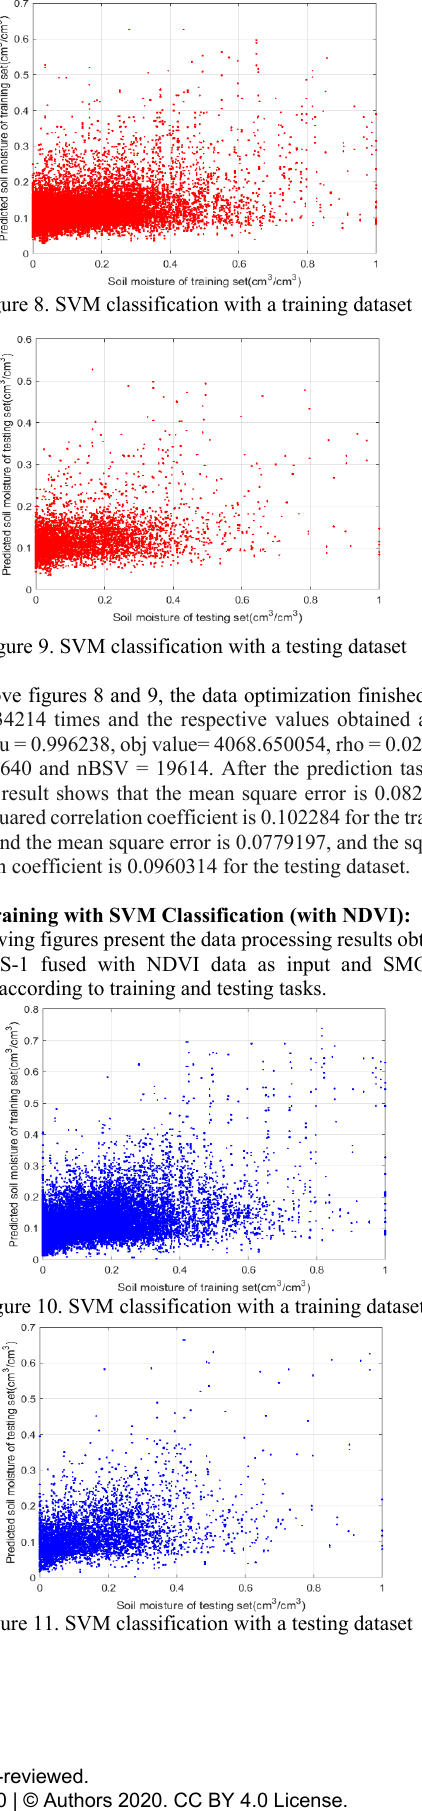
Figure 11. SVM classification with a testing